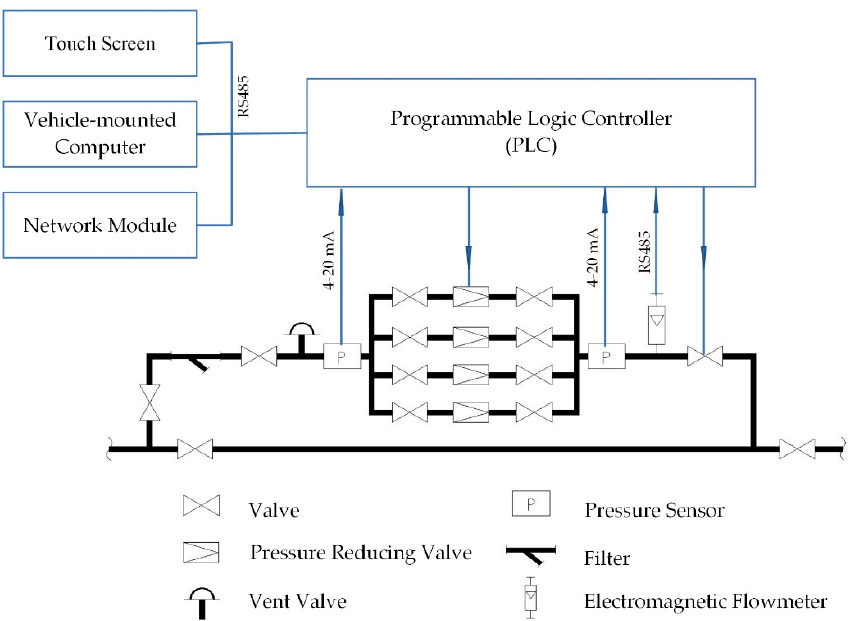
Figure A1. Sensing and control design scheme of the IPRV .